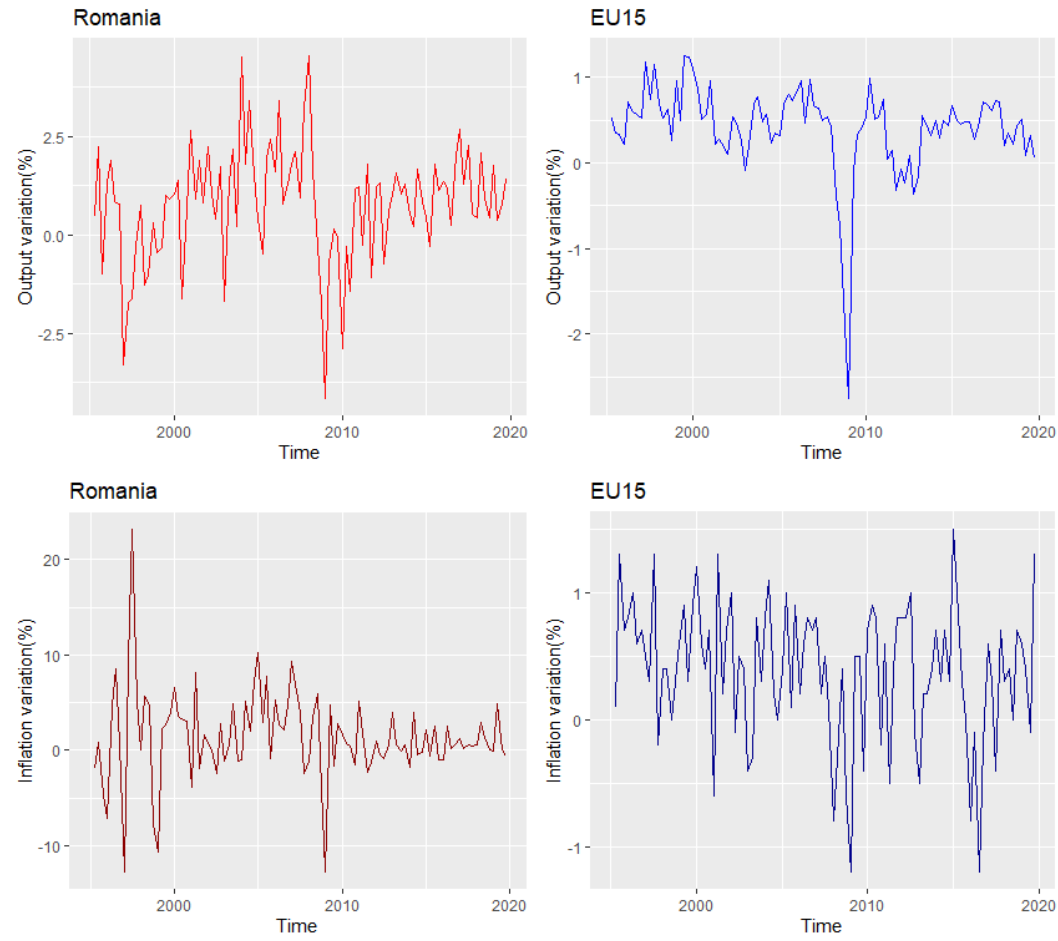
Figure 2. Quarterly output and inflation variation in Romania and EU15 1995q1-2019q4 including. Source: own elaboration with data from